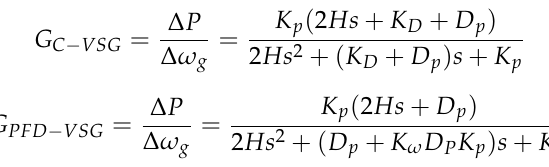
Figure 12. Block diagram of VSG using phase feedforward damping control. The closed-loop transfer functions of conventional VSG(C-VSG) and phase feedfor- ward damping VSG (PFD-VSG) from the grid frequency disturbance to the output active power can be expressed as: